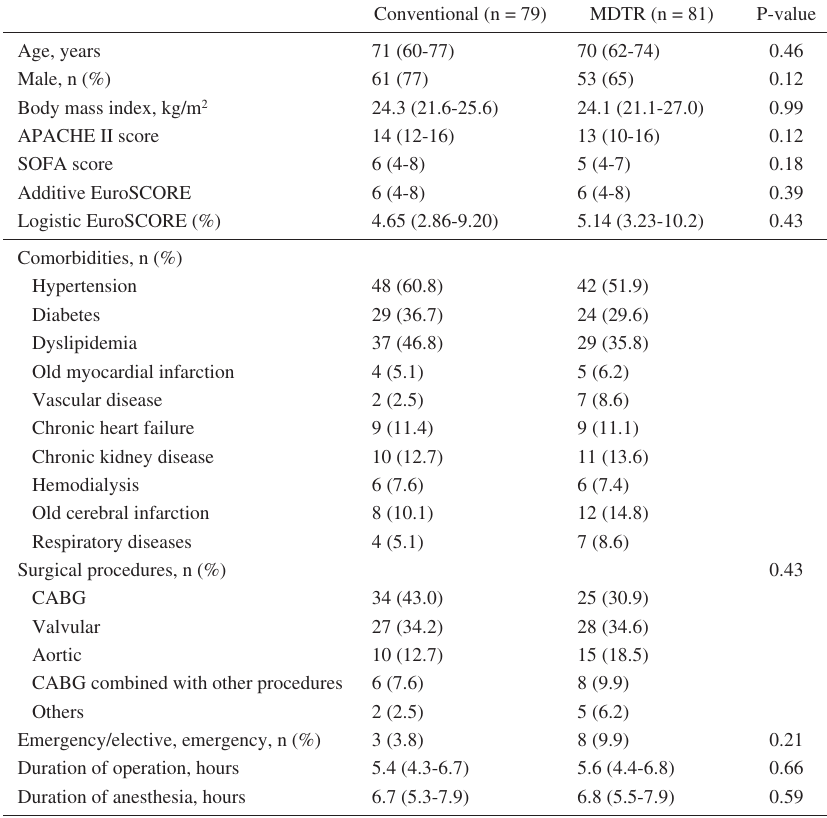
Table 1. Patient’s baseline characteristics.